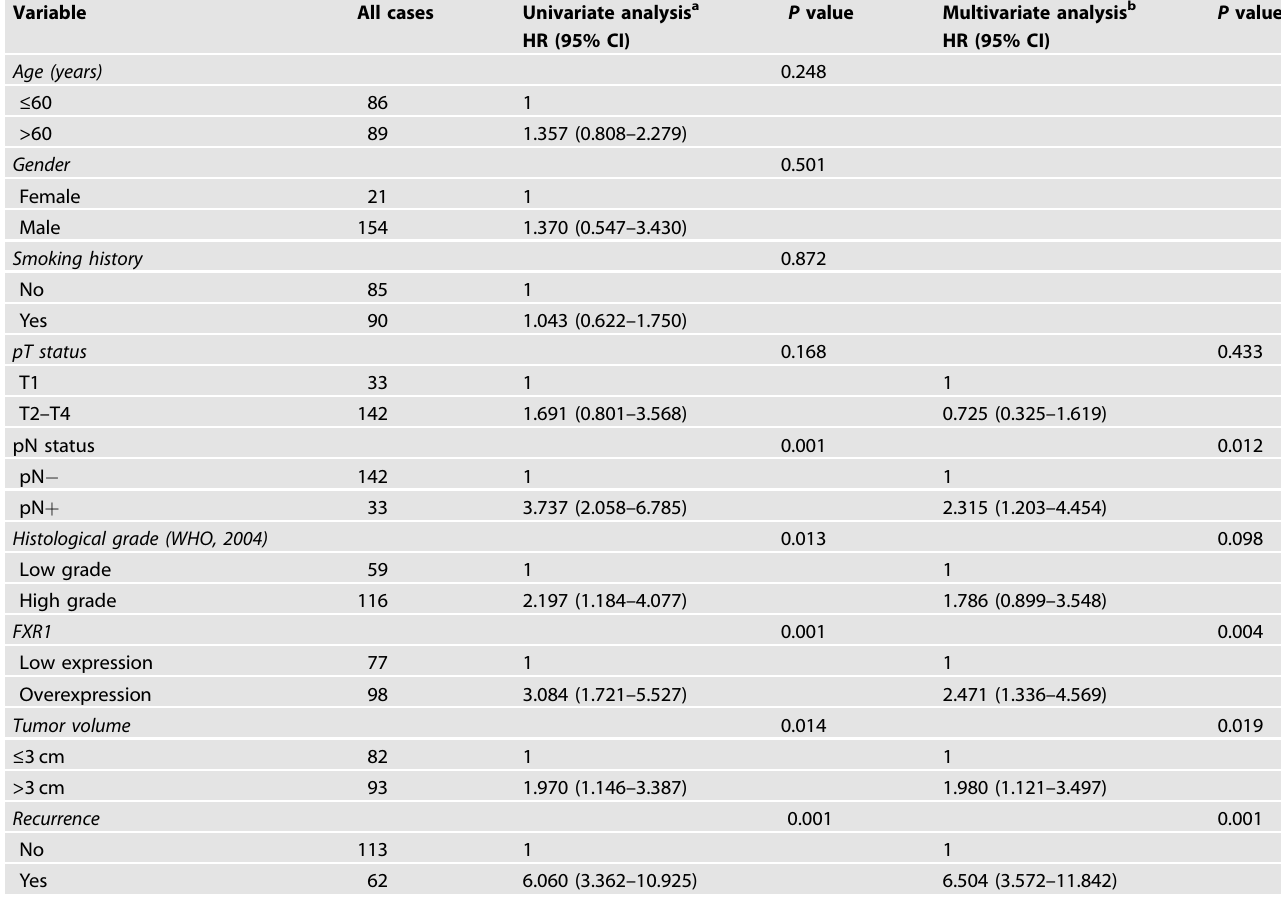
Table 1. Univariate and multivariate analysis of different prognostic parameters in 175 patients with UCB in SYSUCC.